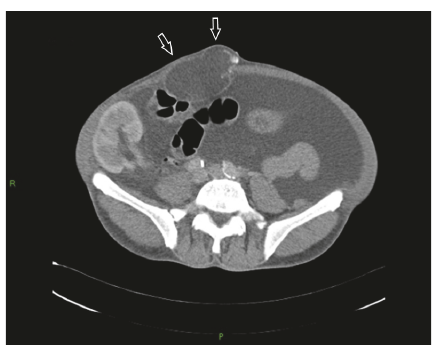
Figure 1: Abdominal CT on admission showed massive ascites and a cystic mass in the abdominal wall (arrows).